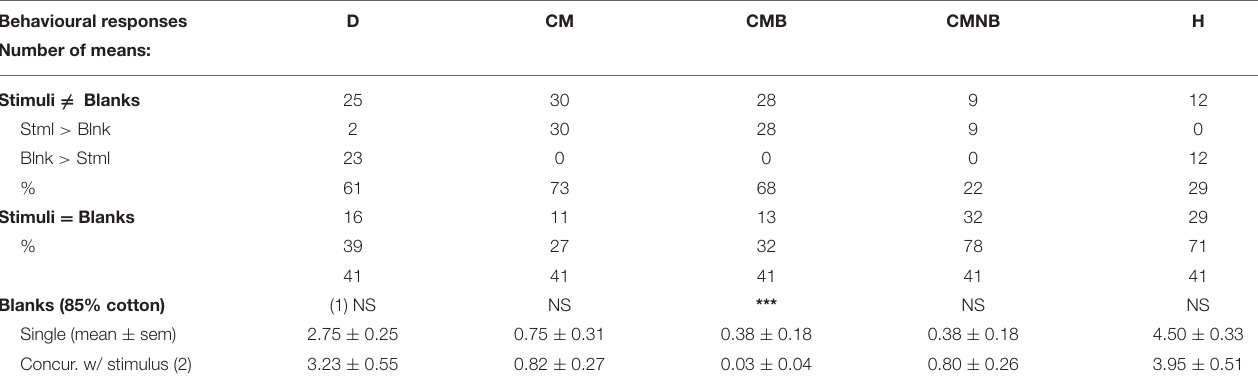
TABLE 4 | Chemical stimuli (41) mean at 1% concentration against concurrent blanks. Behavioural responses